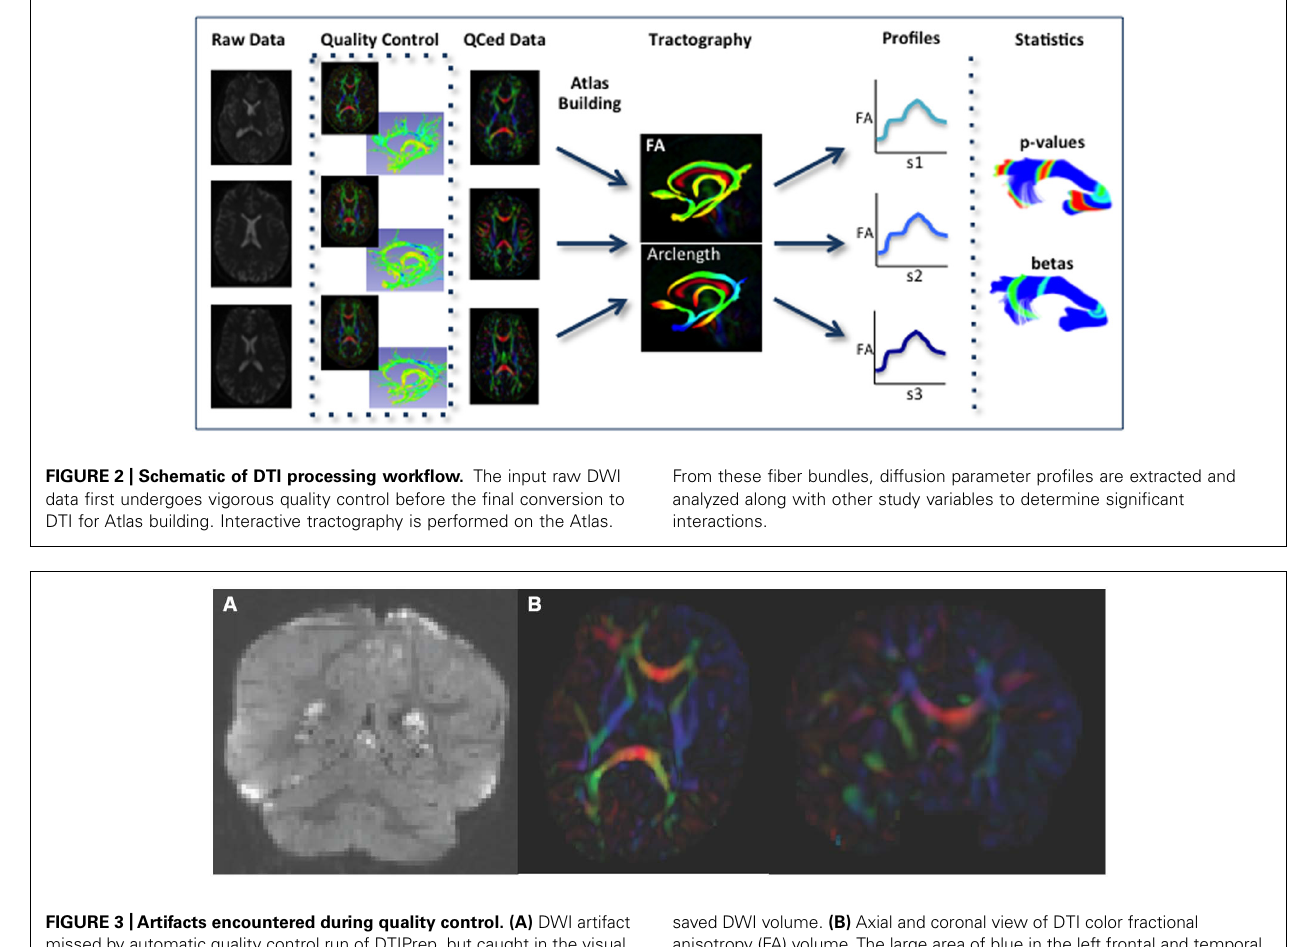
FIGURE 3 |Artifacts encountered during quality control. (A) DWI artifact missed by automatic quality control run of DTIPrep, but caught in the visual quality control.You can see the horizontal lines running through this coronal view of the brain.Toward the top, almost an entire slice is missing. In cases like this, the gradient containing this artifact would be excluded from the